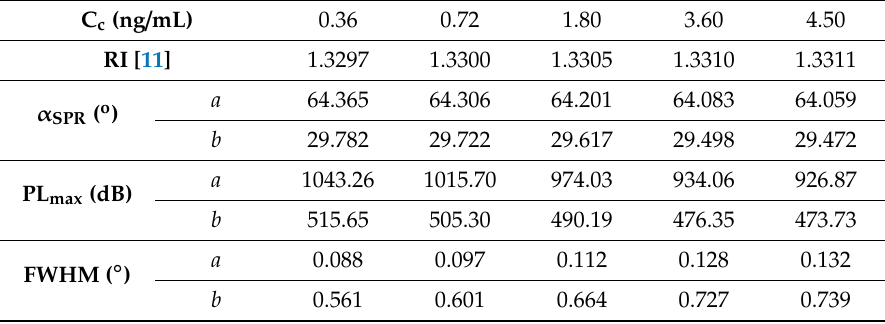
Figure 3. ( a ) Variation of power loss and FWHM with metal layer thickness and ( b ) power loss variation with incident angle for different concentration of cortisol in solution (cortisol ‐ conjugated BSA); d 1 / d = 0.5 (SiC gratings), t Ag = 38.30 nm and λ = 830 nm. Table 2. SiC of 20 nm and 29 nm grating based sensor designs at 830 nm wavelength are 47.10 nm and 38.30 nm, respectively.